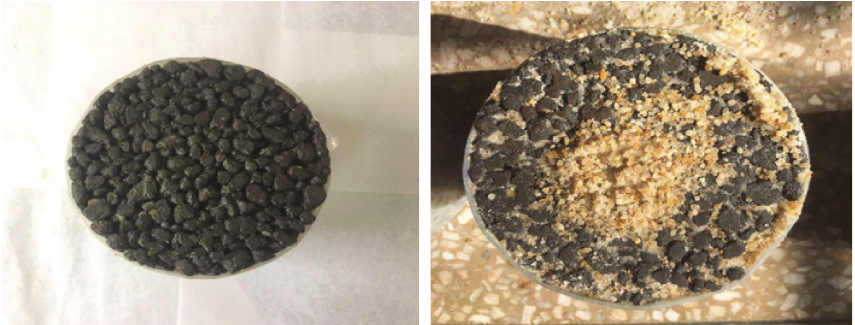
Figure 3: Comparison of PC specimens before and after